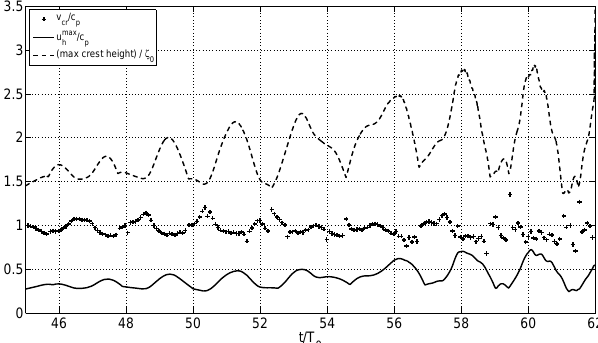
Figure 7. Measured surface elevation η at various locations.